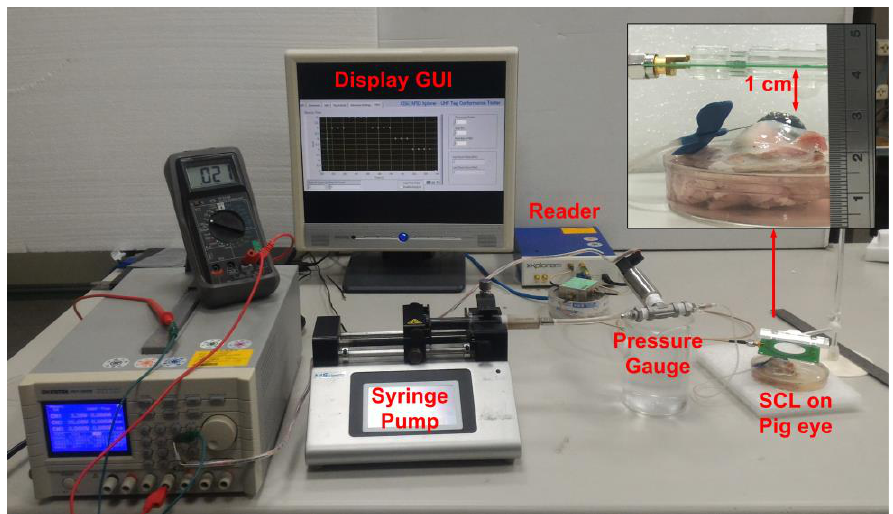
Figure 10. The experimental setup.